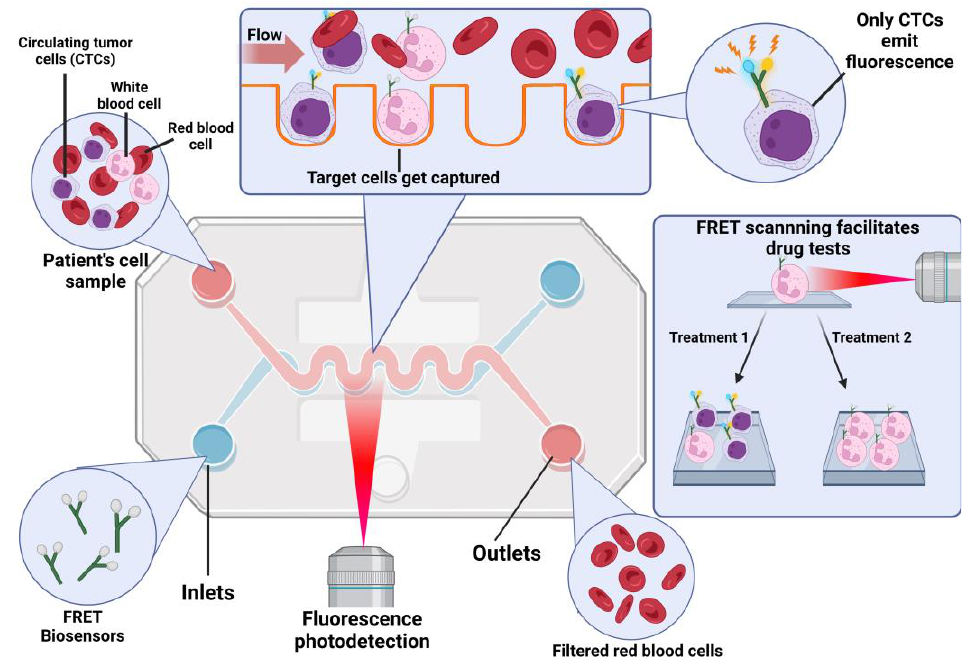
Figure 2. A lab-on-a-chip fluorescence device for biosensing. The device consists of microchannels and sensing regions that allow for the detection and analysis of specific biomolecules in biological samples. Fluorescent probes are used to detect the presence of these biomolecules, and the fluorescence signal is read by a detector integrated into the chip. Created with Biorender.com.